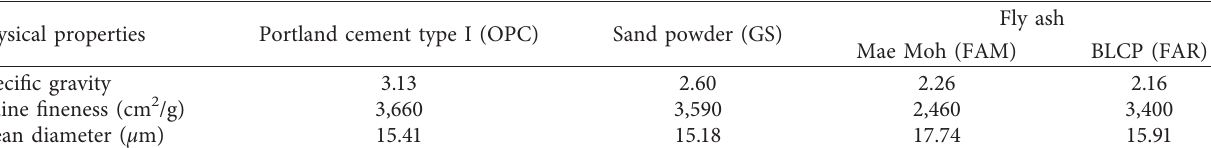
Table 2: Physical properties of Portland cement type I, sand powder, and fly